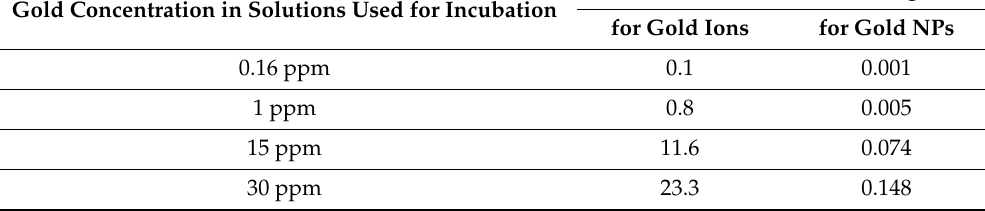
Table 2. Calculated surface coverage for gold ions and gold NPs in solutions at di ff erent gold concentration used for incuba-tion. Coverage of 1 indicates that the substrate surface is completely covered with gold ions or